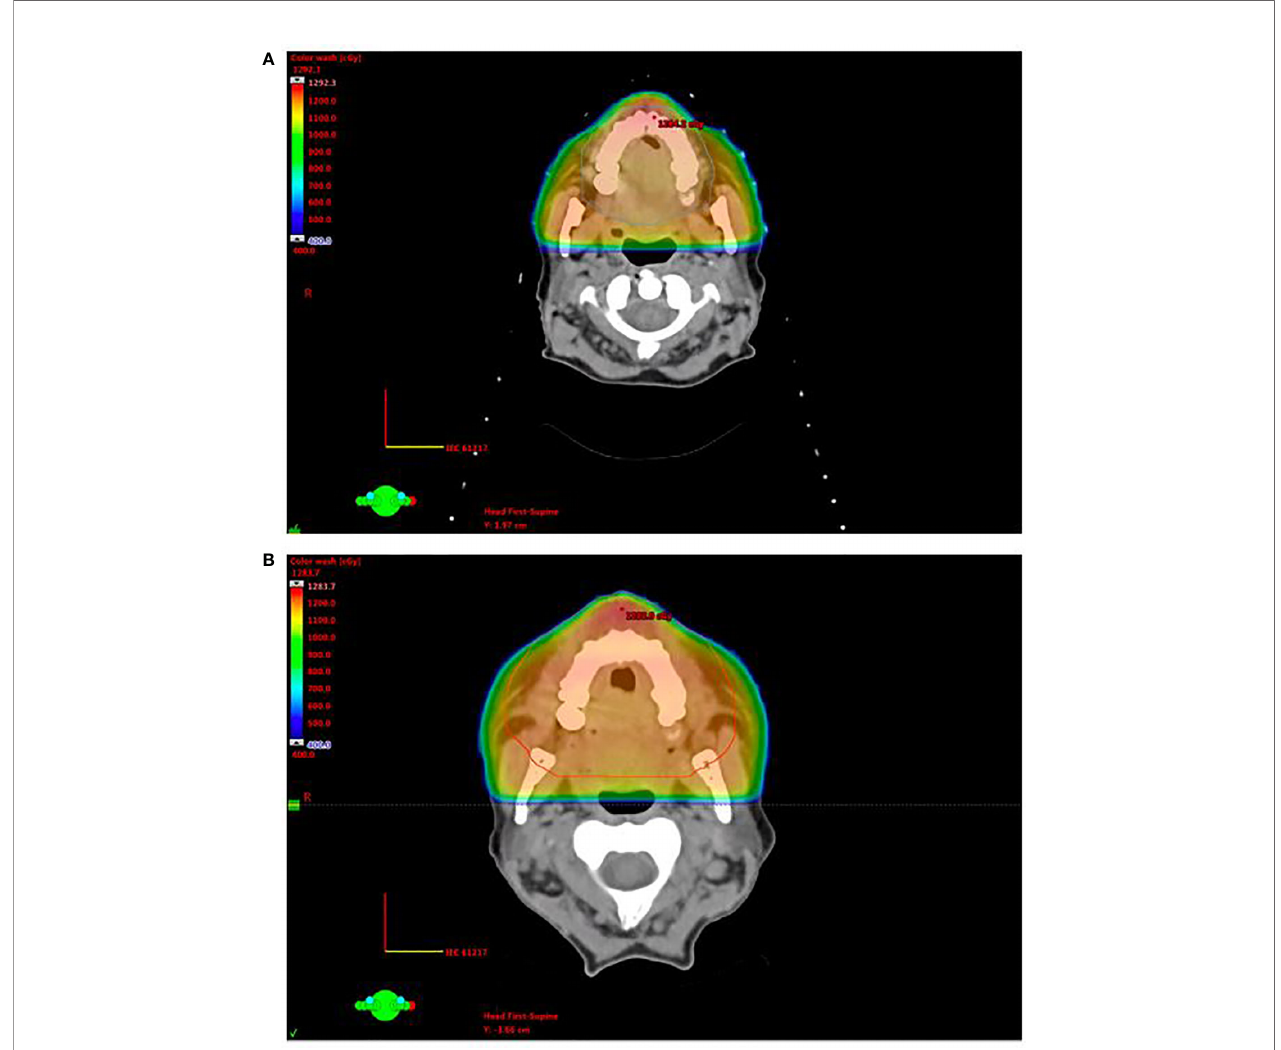
FIGURE 2 | Opposed lateral treatment plans for patient 2, who experienced generalized gingival and hard palate leukemic in fi ltration, on initial treatment (A) and re-treatment (B)